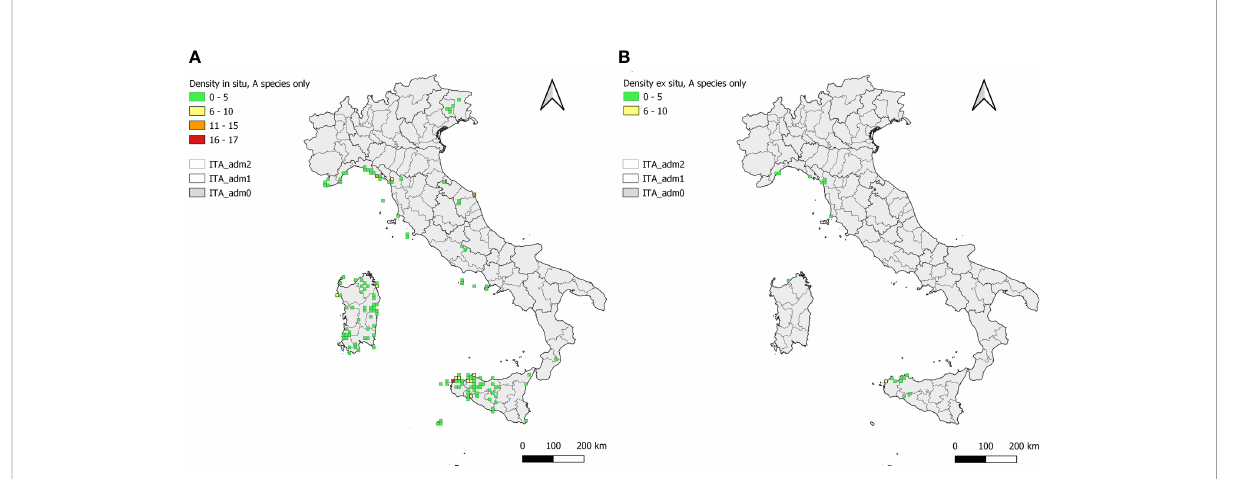
FIGURE 5 Density of in situ (A) and ex situ (B) Brassica CWR population occurrences in cells of side 10 × 10 km. In each map, the Italian territory is subdivided in its administrative Regions and Provinces; cell colours are according to the